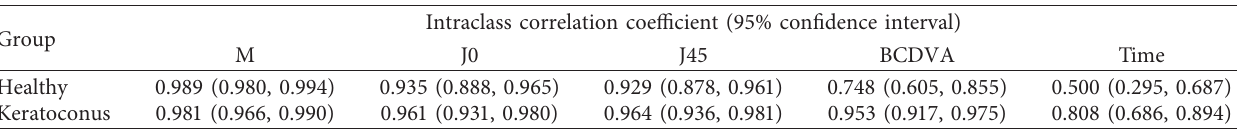
Table 5: Intraclass correlation coefficient (ICC) and its 95% confidence interval for spherical equivalent (M), cylindrical vectors (J0 and J45), binocular corrected visual acuity (BCDVA), and spent time in refraction.